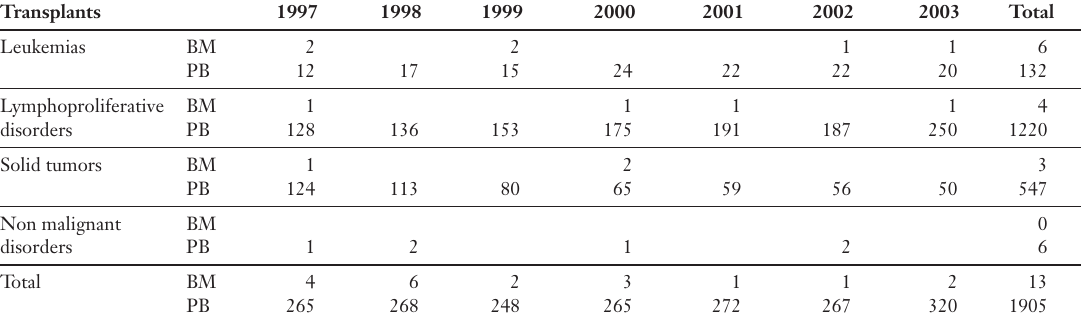
Table 2b: Stern cell source in allogeneic HSCT 1997–2003 Transplants